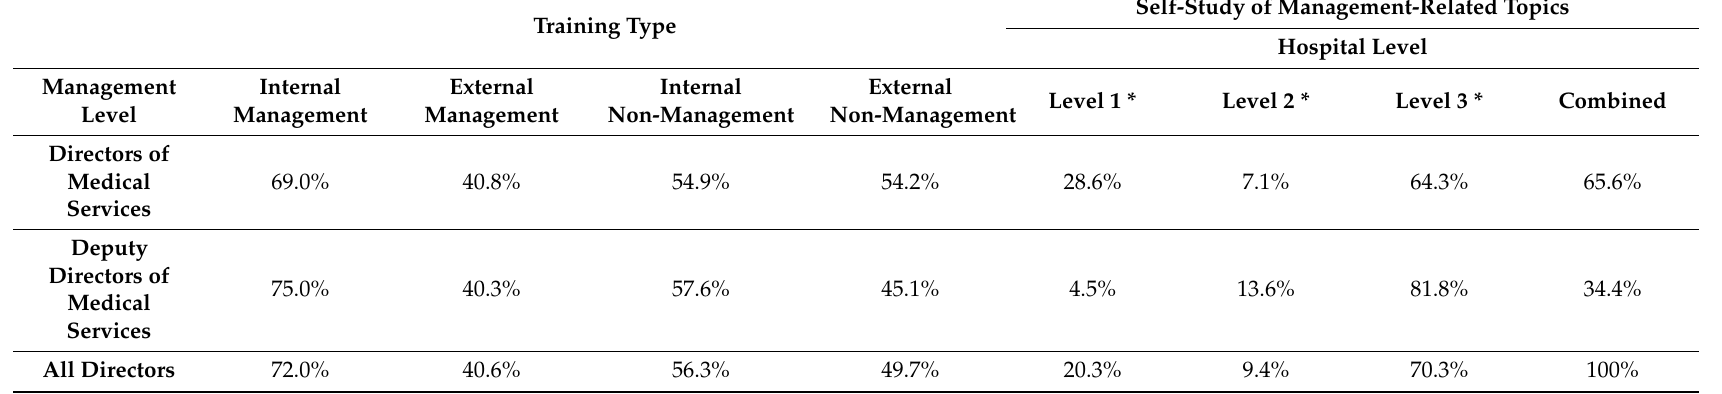
Table 2. Proportion of participants undertaking di ff erent types of informal training for more than 10 h annually by management level, and proportion undertaking self-study by management level and